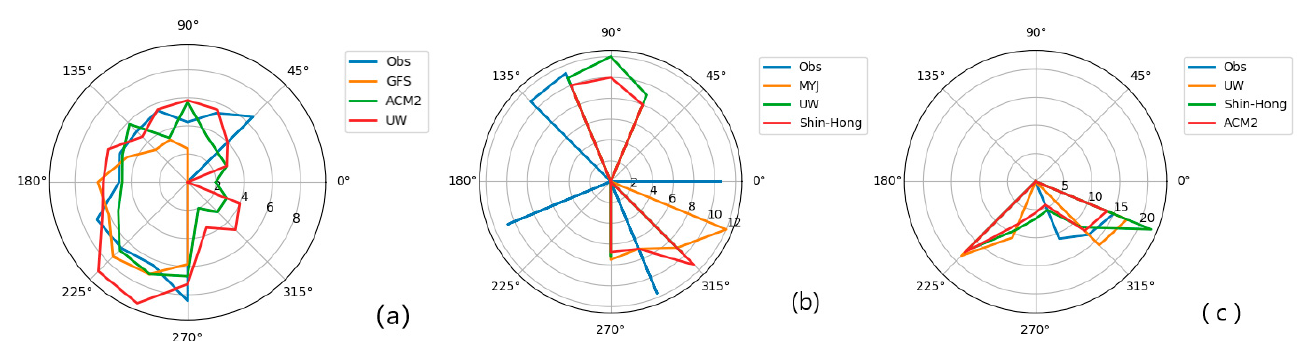
Figure 8. Wind field comparison chart, the observed wind field and simulated wind field with several PBL schemes under different conditions. ( a ) On sunny days, at a height of 300–1000 m, 5 < Obs <10 m · s − 1 , ( b ) On hazy days, at a height of 300–1000 m, 10 < Obs < 15 m · s − 1 , ( c ) On windy days, at a height of 1000–1500 m, 10 < Obs < 15 m · s − 1 .